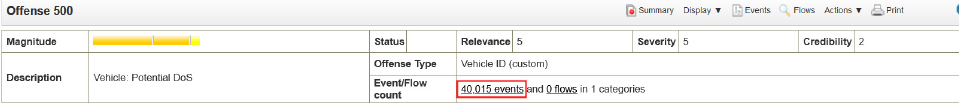
Figure 12. Rule Wizard with the field used to identify the DoS attack.